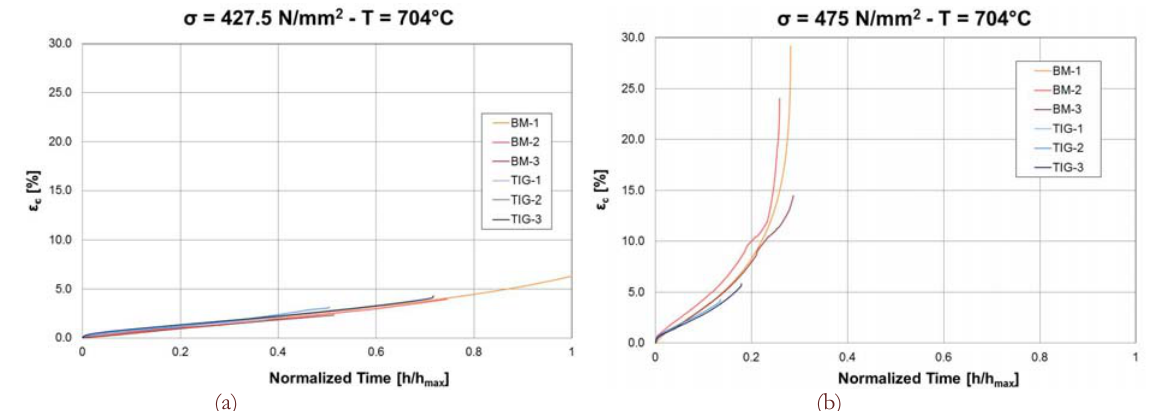
Figure 9: Creep deformation against normalized time at 427.5 MPa (a) and 475 MPa